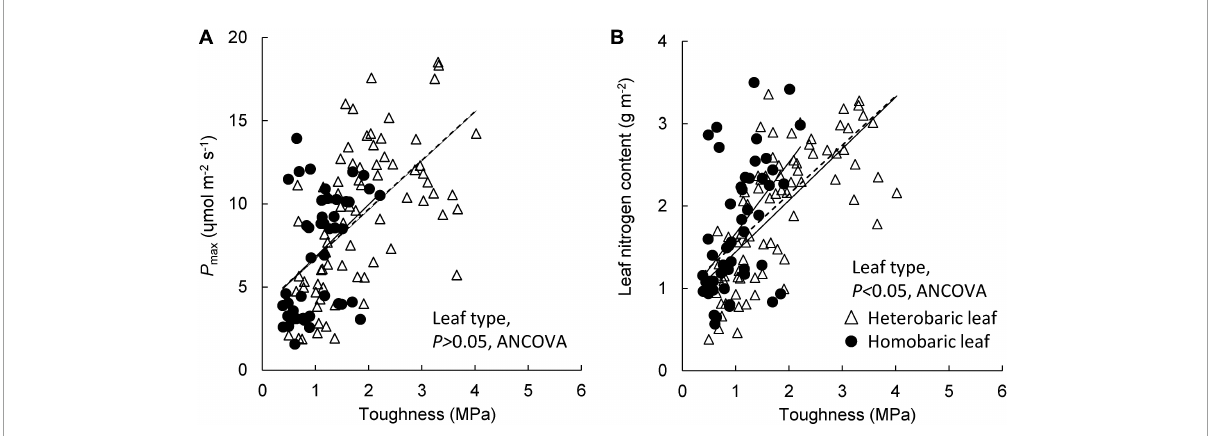
FIGURE6 Leaf toughness in relation to P max (A) and leaf nitrogen content (B) . Regression lines are as follows: (A) heterobaric leaf, r 2 = 0.36, P < 0.0001; homobaric leaf, r 2 = 0.18, P < 0.01; (B) heterobaric leaf, r 2 = 0.50, P < 0.0001; homobaric leaf, r 2 = 0.28, P < 0.0001. Details of the results of ANCOVA appear in Appendix 10. Dotted line means regression line for pooled data for both leaf